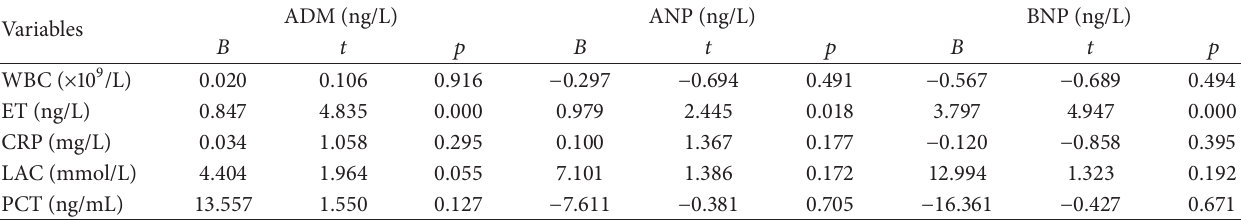
Table 4: Stepwise multiple regression analysis of significant factors for ADM, ANP, and BNP in uroseptic patients.